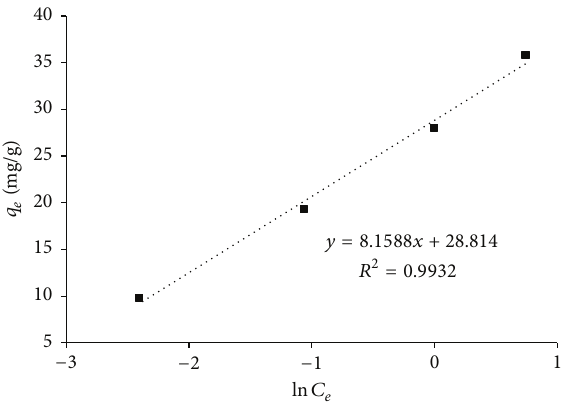
Figure 12: D-R isotherm (pH = 5.6, 𝐶 0 = 5–20 mg/L, dose = 0.5 g/L, contact time = 180min, and temperature = 30 ∘